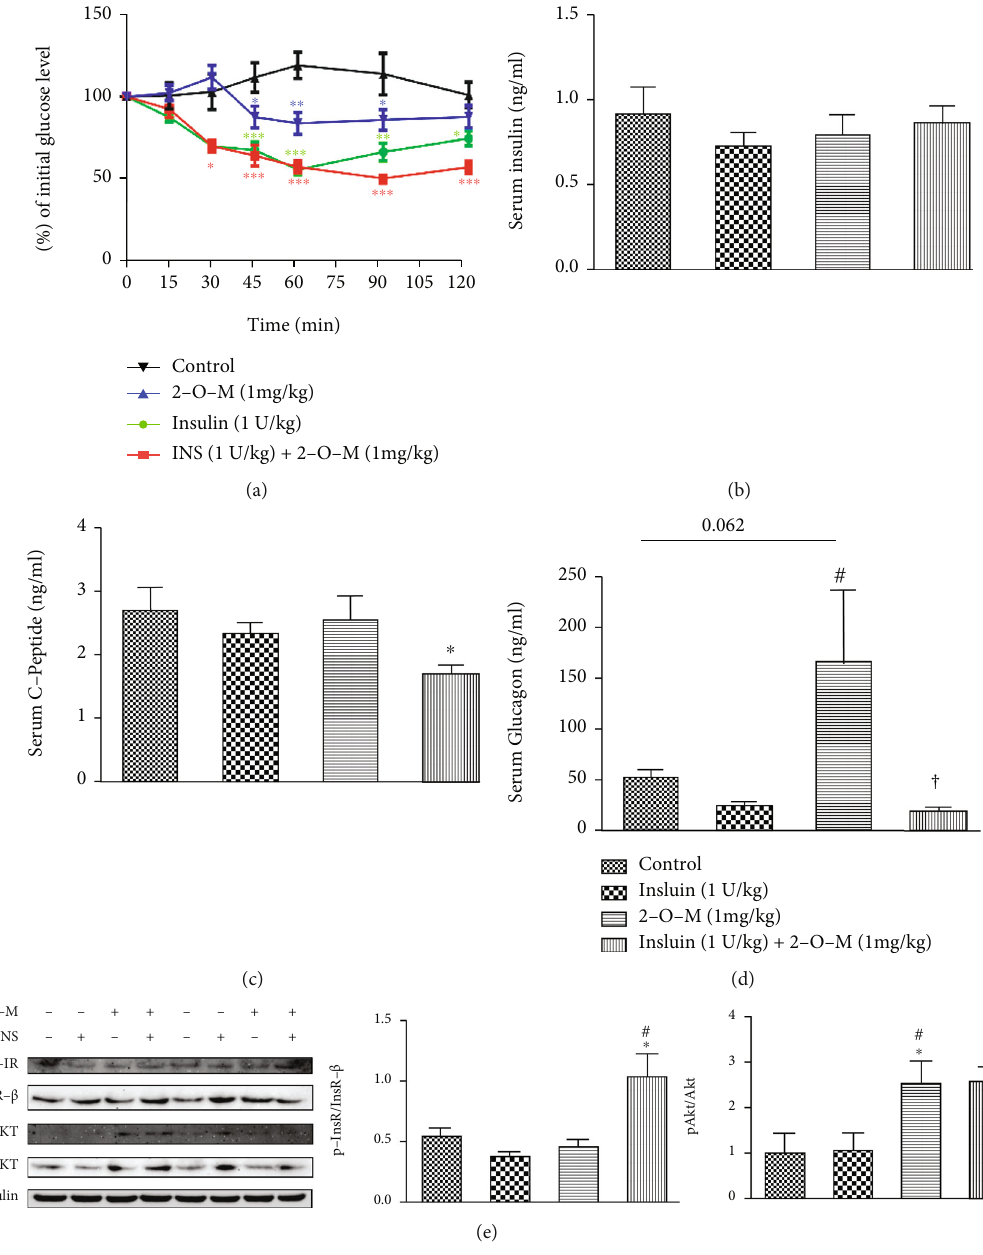
Figure 6: The e ff ect of 2 ′ -O-methylperlatolic acid (2-O-M) on glycogen synthesis, fat synthesis, and gluconeogenesis genes in vivo . (a – e) Genes in the liver. Genes in the muscle. Data are shown as the mean ± SEM ( n = 4 – 8 in each group). ∗ p < 0 : 05 ; ∗∗ p < 0 : 01 ; ∗∗∗ p < 0 : 001 versus control. # p < 0 : 05 ; ## p < 0 : 01 ; ### p < 0 : 001 versus insulin. † p < 0 : 05 ; †† p < 0 : 01 , 2-O-M versus